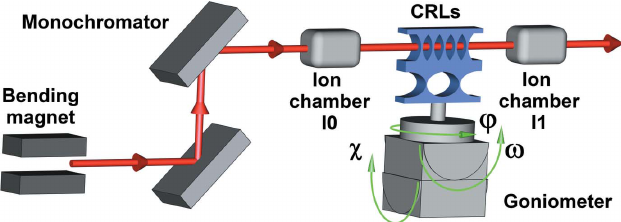
Figure 1 Experimental setup. The beam from the bending magnet is incident on the double-crystal monochromator. The intensity of the beam is measured with ion chambers before (I0) and after (I1) the sample. The sample (here a 1D CRL) can be rotated around all three